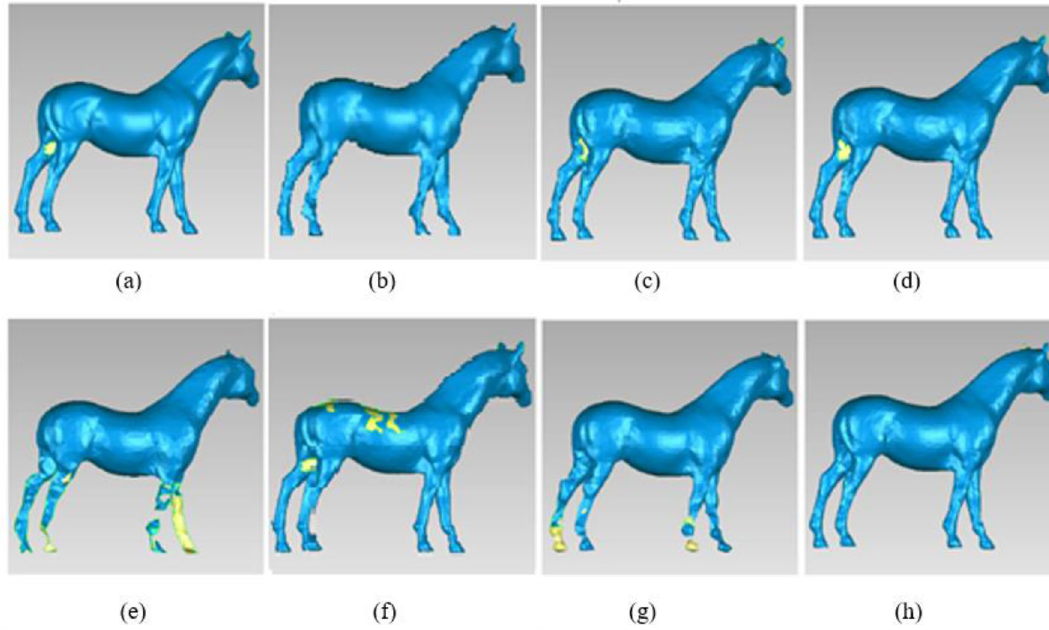
Figure 16. Different simplified results of Horse. ( a ) Original data. ( b ) Our method. ( c ) The simplified method based on DFPSA. ( d ) The simplified method based on Gaussian spheres. ( e ) The simplified method based on octree coding. ( f ) The k-means clustering simplification method. ( g ) The uniform simplification method. ( h ) The geometric algebra